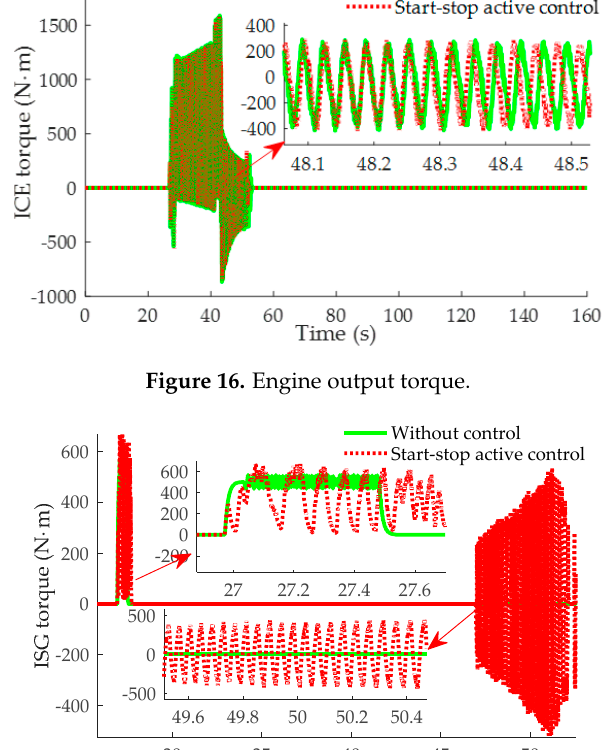
Figure 17. Integrated starter generator (ISG) motor output torque.